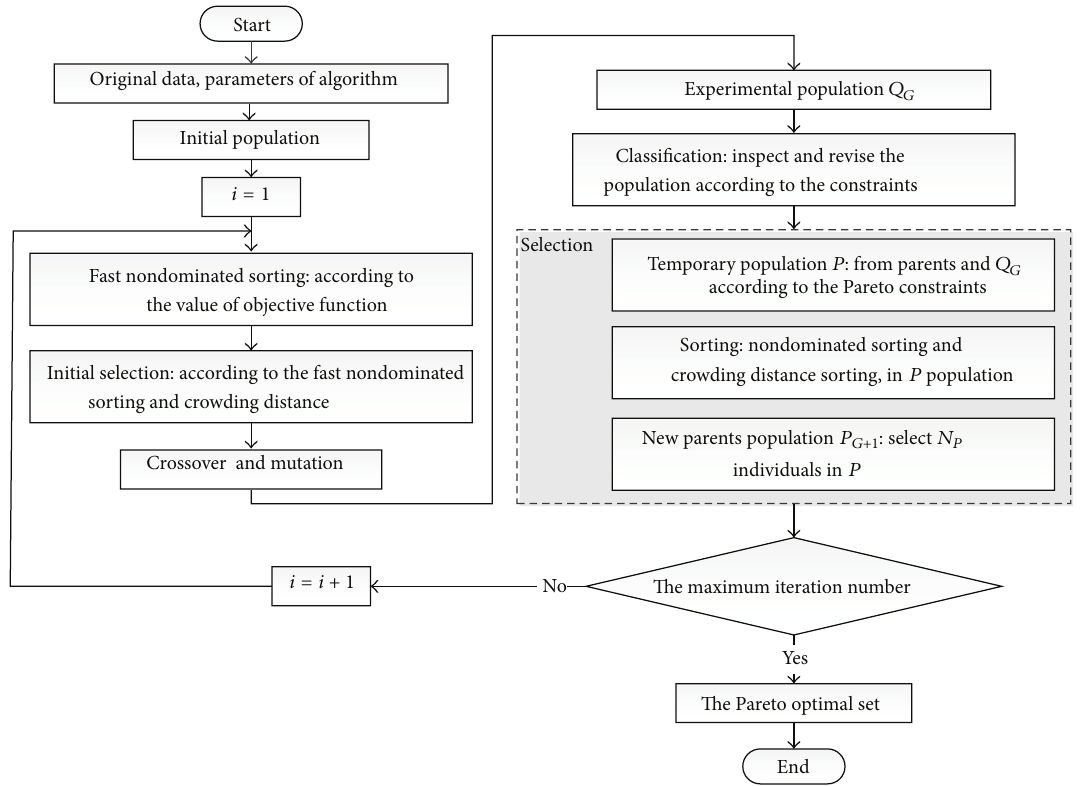
Figure 4: The process of the power allocation strategy by NSGA-II.